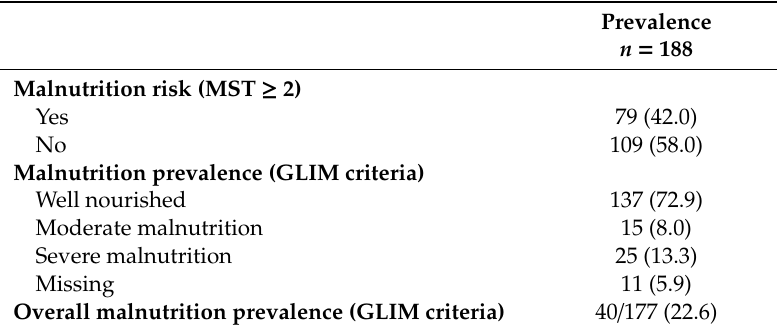
Table 4. Prevalence of malnutrition risk and malnutrition ( n = 188).